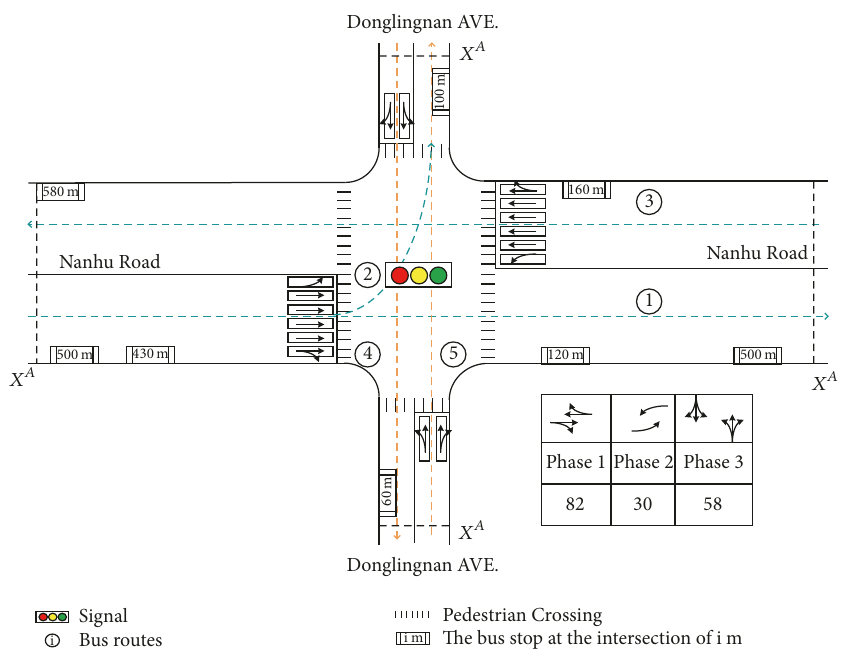
Figure 1: Layout of the